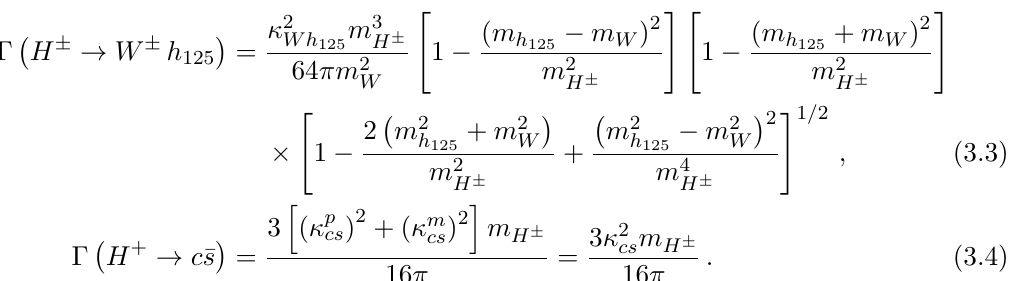
H (cid:6) ) =(cid:20) 2 = (cid:27) 0 ( m ) as a function of m H (cid:6) cs !